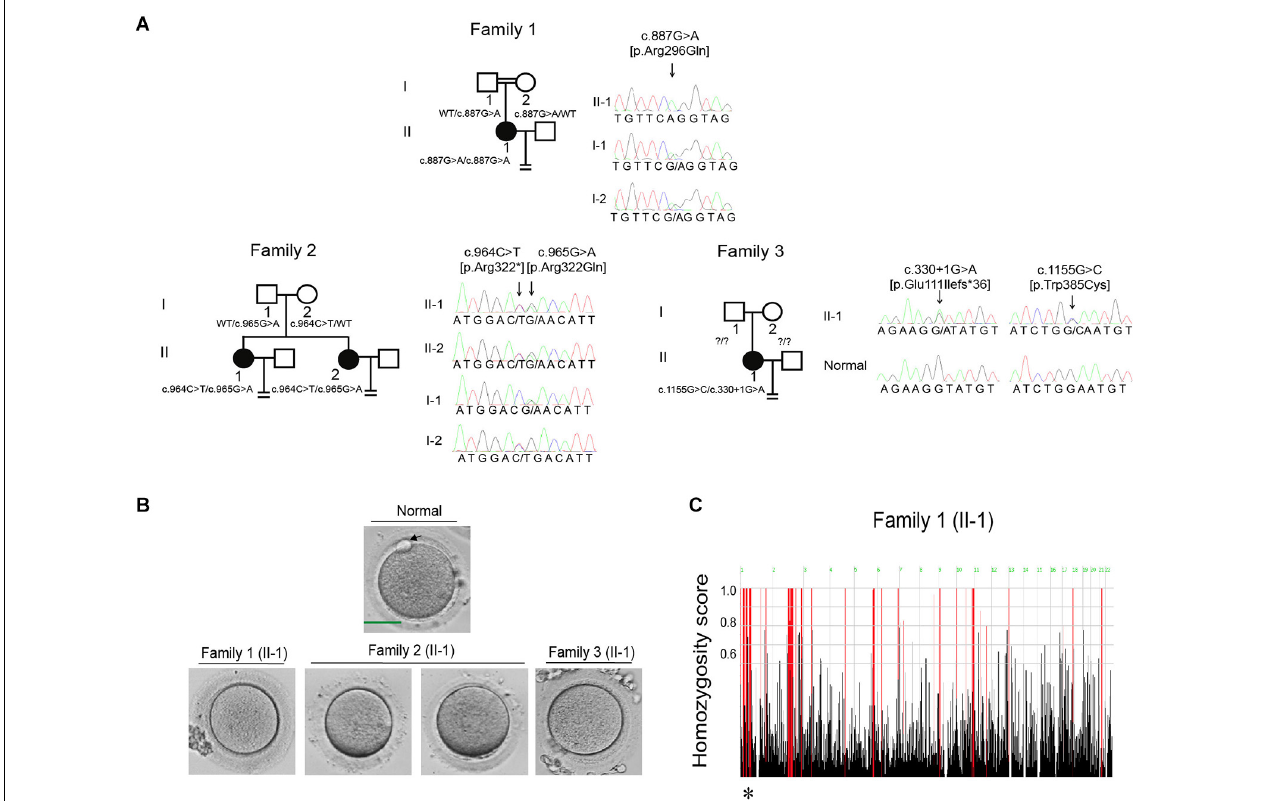
FIGURE 1 | Pedigrees and the identification of mutations in CDC20 . (A) Three pedigrees presented with oocyte maturation arrest and fertilization failure. Sanger sequencing confirmation is shown to the right of the pedigrees. Question marks indicate unavailable DNA samples. “Normal” represents the fertile control individual. Squares denote male family members, circles denote female members, black solid circles denote probands, the double lines between the parents in family 1 denote consanguineous marriage, and the equal sign denotes infertility. (B) The oocyte morphology of normal and affected individuals. The black arrow indicates PB1. Scale bar = 40 µ m. (C) Homozygosity mapping of individual II-1 in family 1. Homozygous regions harboring the strongest signal are indicated in red, and the asterisk ( ∗ ) indicates the area where CDC20 is